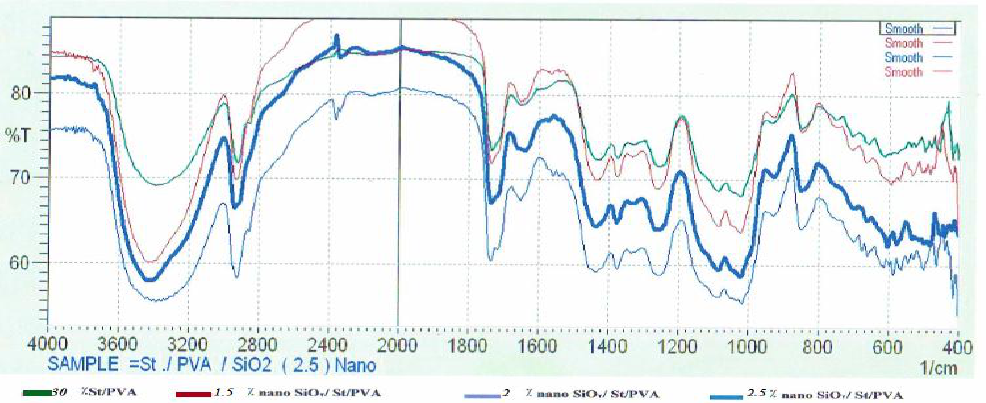
Fig. 9: FTIR spectra of micro SiO